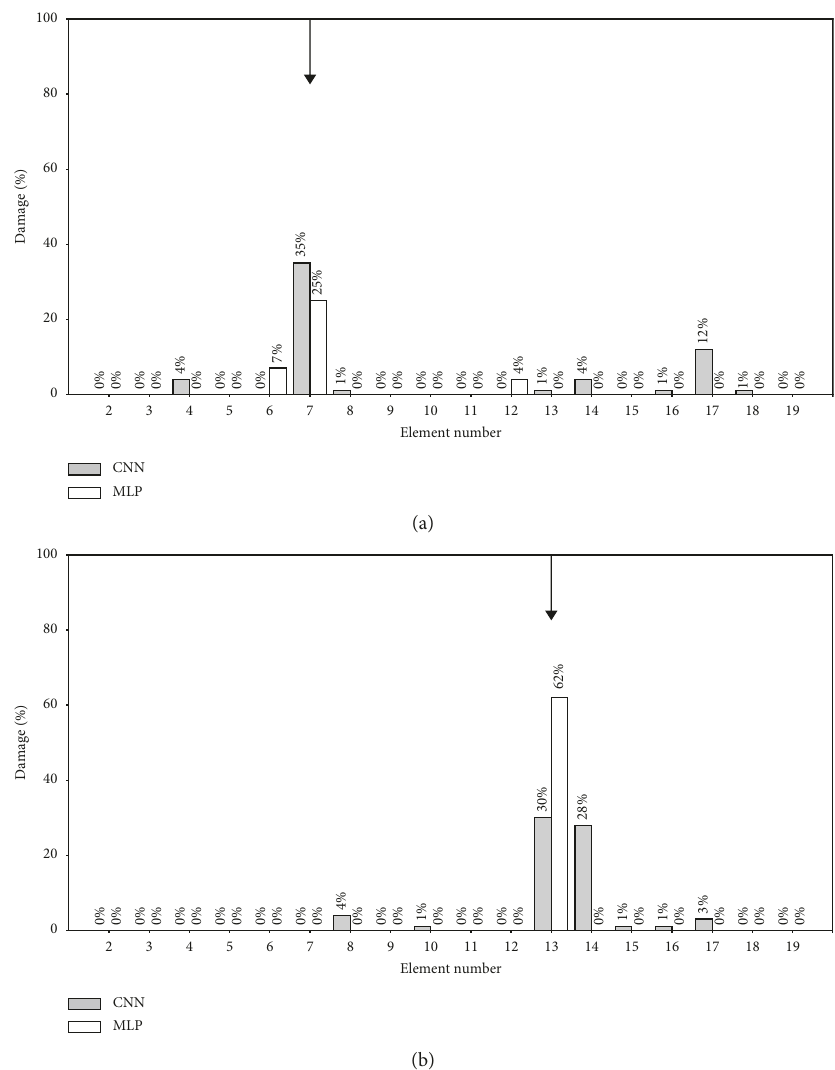
Figure 29: Comparison of CNN-based model 2 and MLP from [27]. Experimental cases 1 (a) and 2